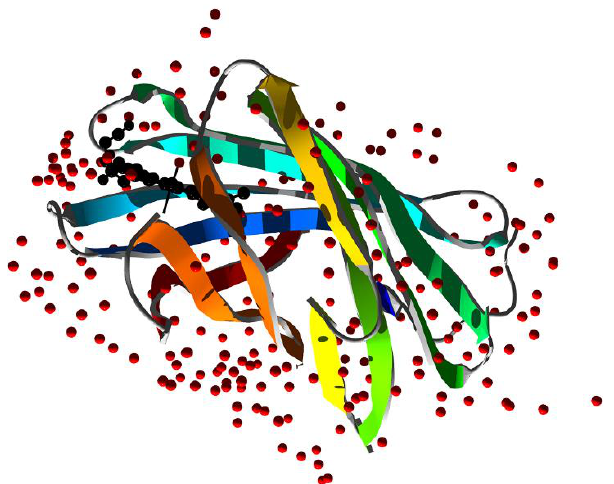
Figure 7. X-ray structure of M. tuberculosis nitrobindin (PDB ID 6R3W [30]). Ribbons are colored following secondary structure succession. Heme is rendered in black and water molecules as red spheres.